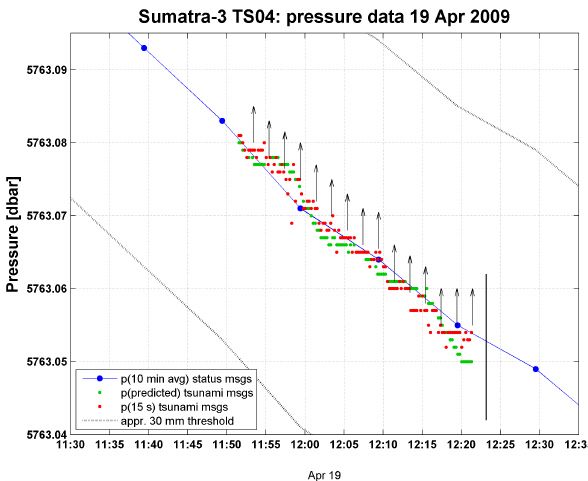
Fig. 18. Status information from BU 002 at location Sumatra 4. Legend as follows unless self explaining: B(HAM), cyan = mo- dem voltage in V; B(REL), magenta = emergency release voltage; B(CTR), blue = BU-controller voltage; Tilt X and Y (blue, red) = tilt of bottom unit relative to vertical; Missing Msg ID (green) = number of missing messages since last transmission due to commu- nication failures (“0” indicates zero lost messages, “1” i.e. a single lost message, etc.). No tsunami alarm occurred at this unit.